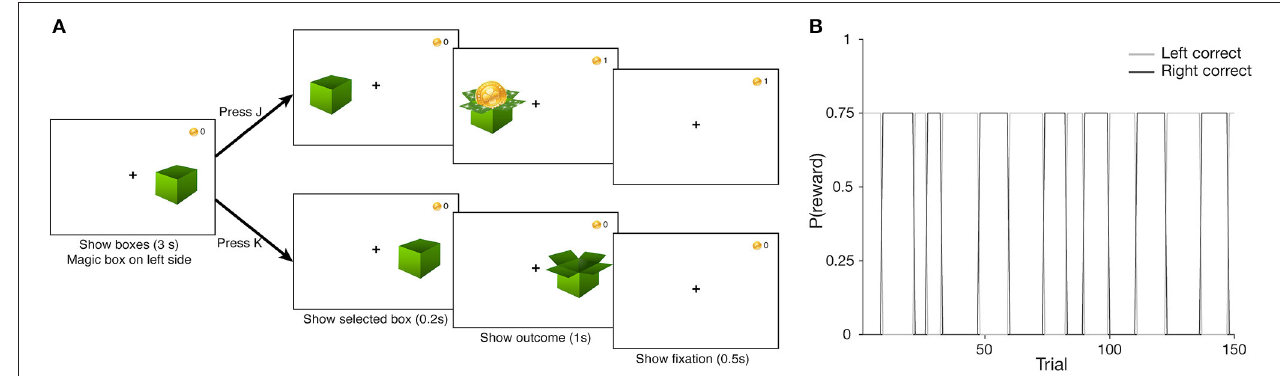
FIGURE 1 | (A) Probabilistic Switching task design. Participants saw two boxes at the start of the trial, and had 3s to choose a box via key press (“J” to select the left, “K” for the right). After a 0.2s delay, where only the selected box was shown, the outcome was shown for 0.5 s—a coin if the participant was rewarded, and an empty box otherwise; points total was updated in the top right corner of the. Finally, a screen with only the fixation cross was shown for 0.5s to signal the start of the upcoming trial. (B) Task block structure. The correct box identity reverses unpredictably over a block. Correct box selection leads to a coin with a reward probability p ( rew ) = 0.75, while selecting the incorrect box never leads to a coin [ p ( rew ) =